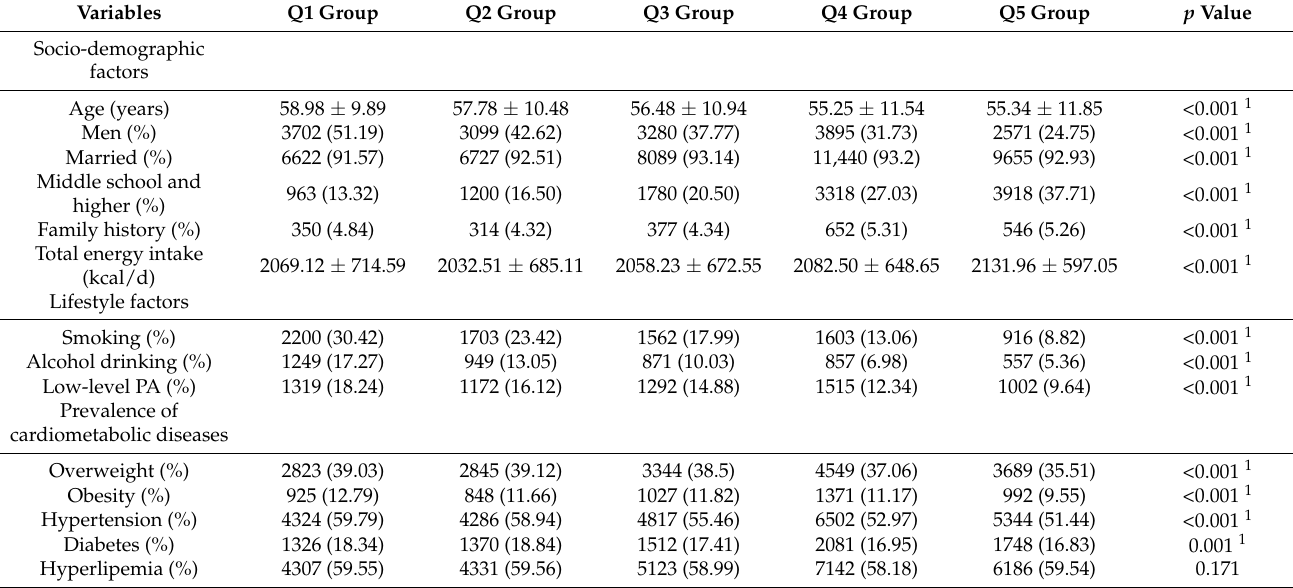
Table 1. Baseline characteristics of participants according to DASH dietary groups.